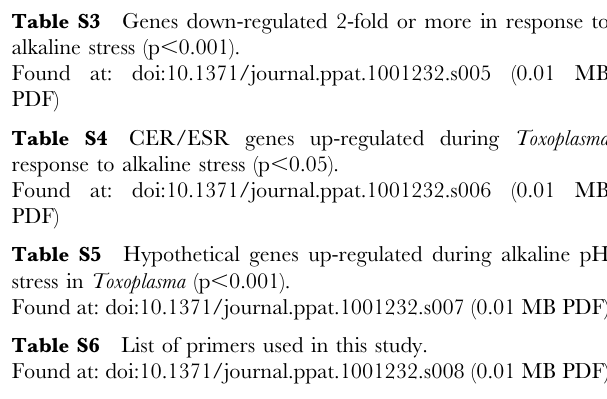
Table S2 Transcripts that are induced . 2-fold in Toxoplasma grown in alkaline medium.